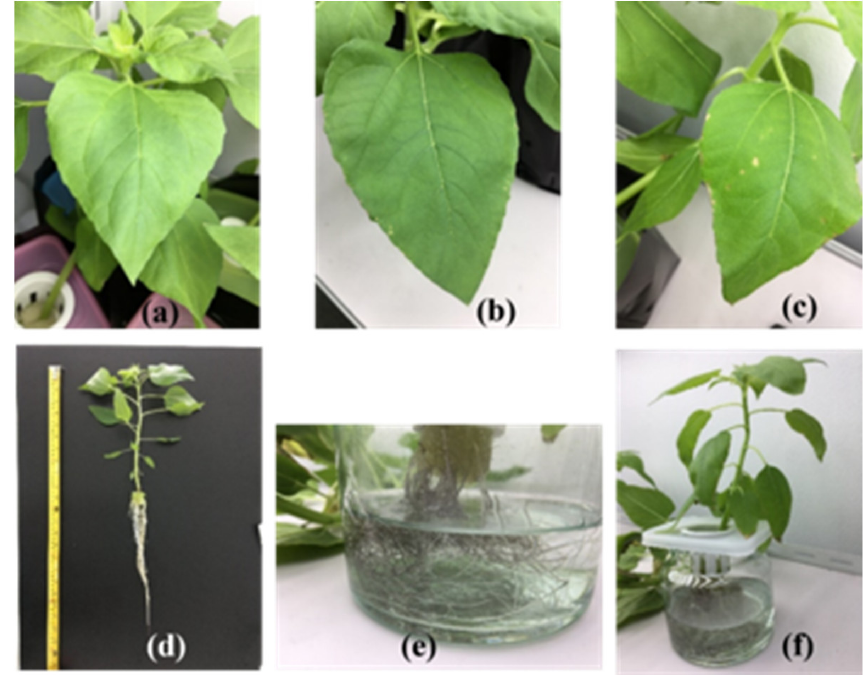
Figure 2. Toxicity in sunflower after 4 days of cultivation for carbaryl treatments at 0 mg L −1 ( a ), 5 mg L −1 ( b ), and 10 mg L −1 ( c ), after 12 days cultivation (control) ( d ), and gray roots for carbaryl at 10 mg L −1 ( e , f ).